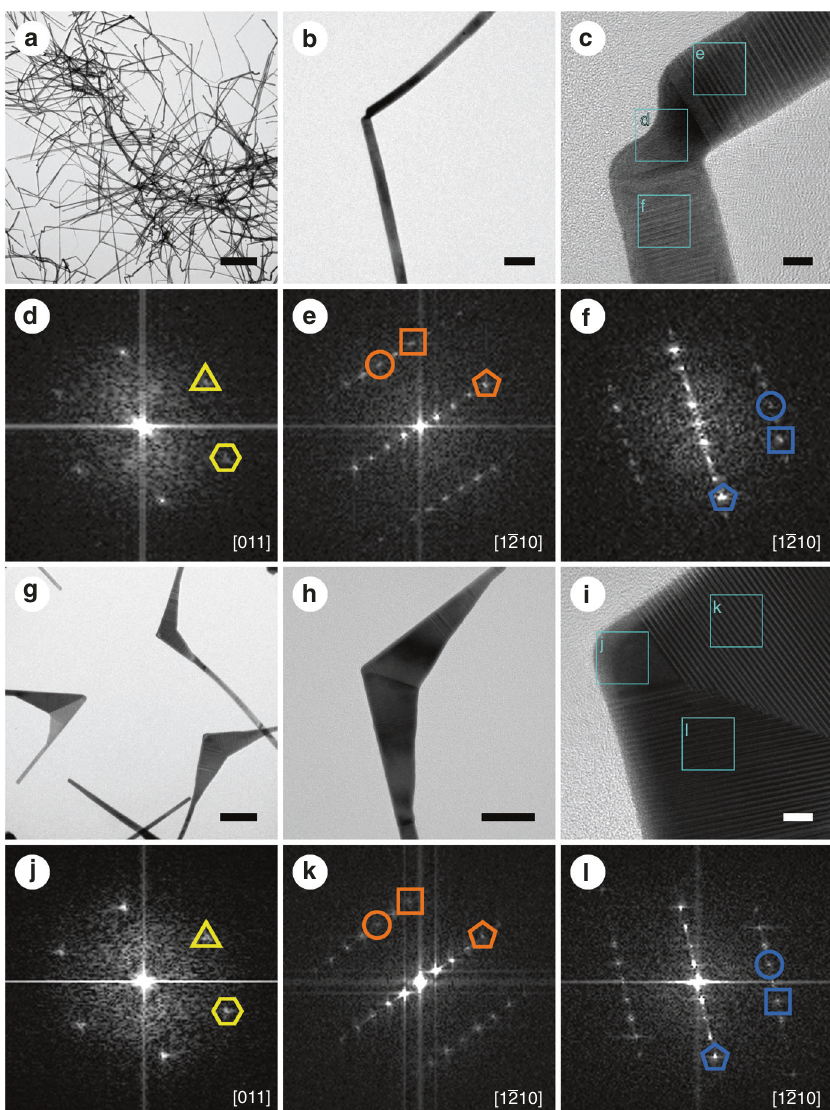
Fig. 1 Structural characterizations of bent Au nanoribbons and Au nanokites. a Transmission electron microscopy (TEM) image of bent Au nanoribbons. b TEM image of a typical bent Au nanoribbon. c – f High-resolution transmission electron microscopy (HRTEM) image of the curved area of the bent Au nanoribbon with marked areas and their corresponding fast Fourier transform (FFT) patterns. (1 1 (cid:1) 1) and (2 0 0) spots of face-centered cubic (fcc) phase are marked with yellow triangles and hexagons, respectively. (0 0 0 4), (1 0 (cid:1) 1 0), and (1 0 (cid:1) 1 2) spots of 4H phase are marked with pentagons, circles, and squares, respectively. The orange and blue represent different 4H sub-crystals. g TEM image of Au nanokites. h TEM image of a typical Au nanokite. i – l HRTEM image of the head of the Au nanokite with marked areas and their corresponding FFT patterns. Scale bars, a 1 µ m; b 50 nm; c 5 nm; g 100 nm; h 50 nm; i 5